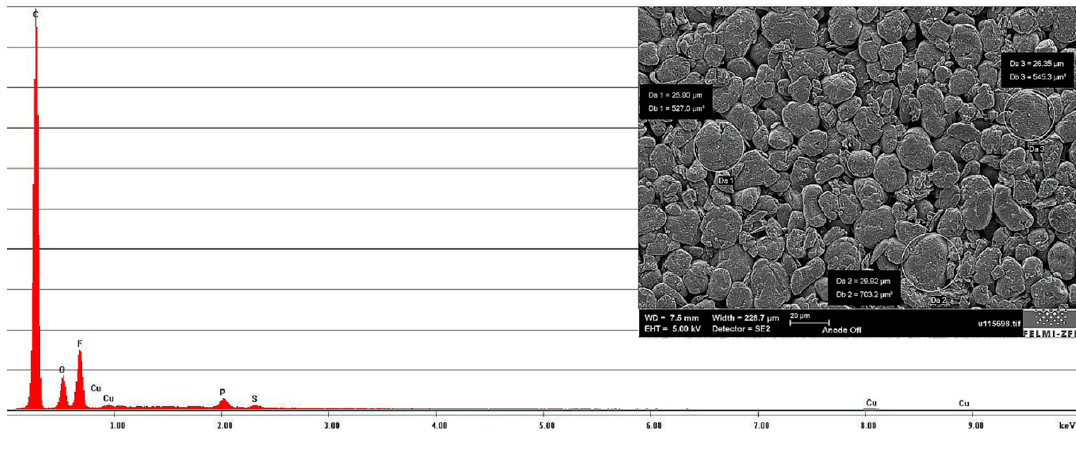
Figure 9. Anode surface image with measured grain size and energy dispersive X-ray spectroscopy (EDXS)-spectrum of the anode, showing the chemical elements on the anode surface.